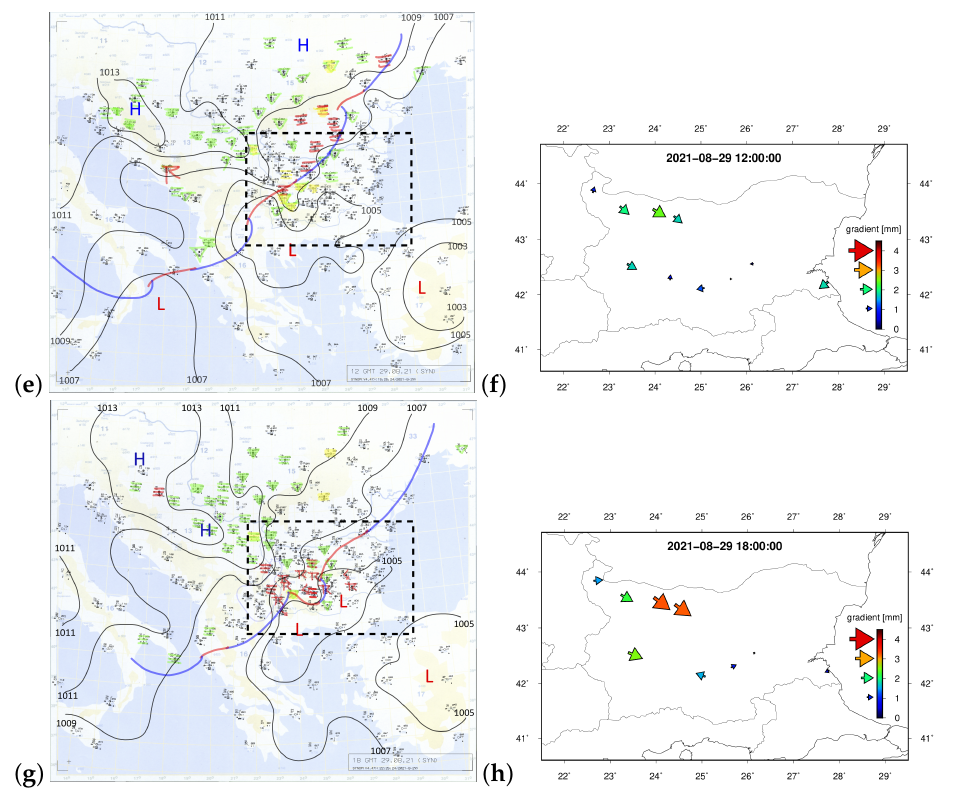
Figure 9. Surface weather charts for the Balkan peninsula at ( a ) 12 UTC on 28 August, ( c ) 18 UTC on 28 August, ( e ) 12 UTC on 29 August and ( g ) 18 UTC on 29 August. ZTD gradients over Bulgaria at ( b ) 12 UTC on 28 August, ( d ) 18 UTC on 28 August, ( f ) 12 UTC on 29 August and ( h ) 18 UTC on 29